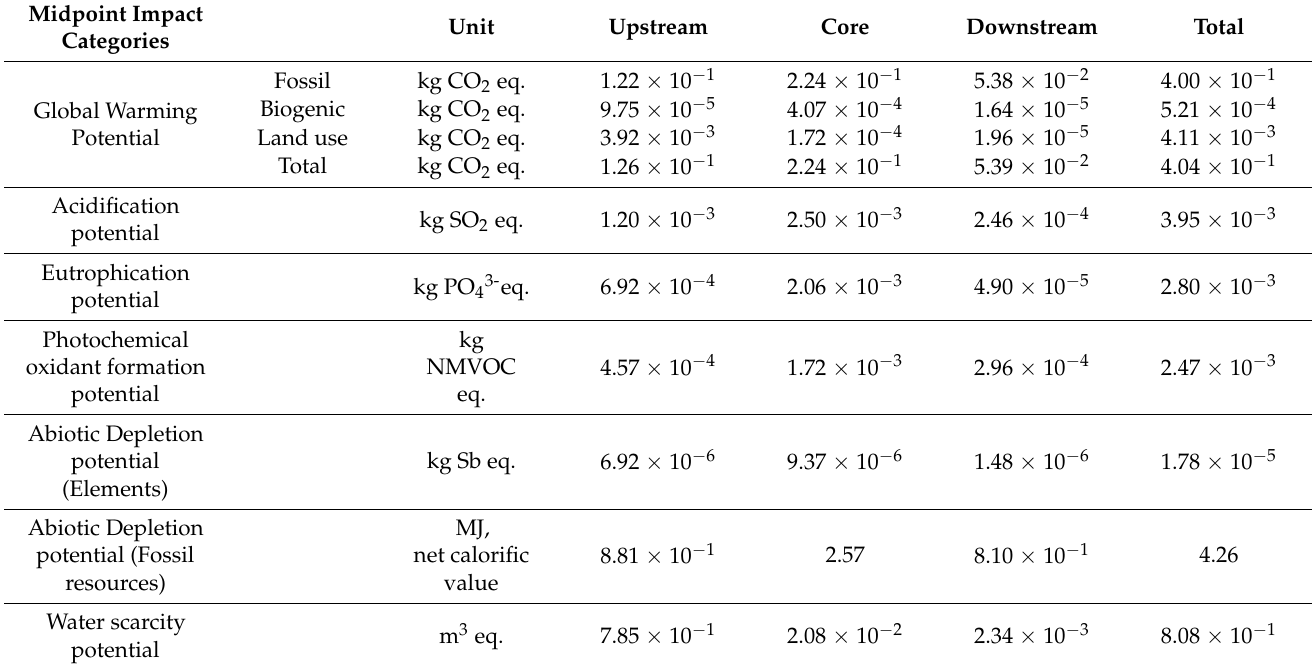
Table 7. Midpoint LCA indicators of 1 kg of durum wheat produced under conventional cultivation. Source of the data: EPD International [131].